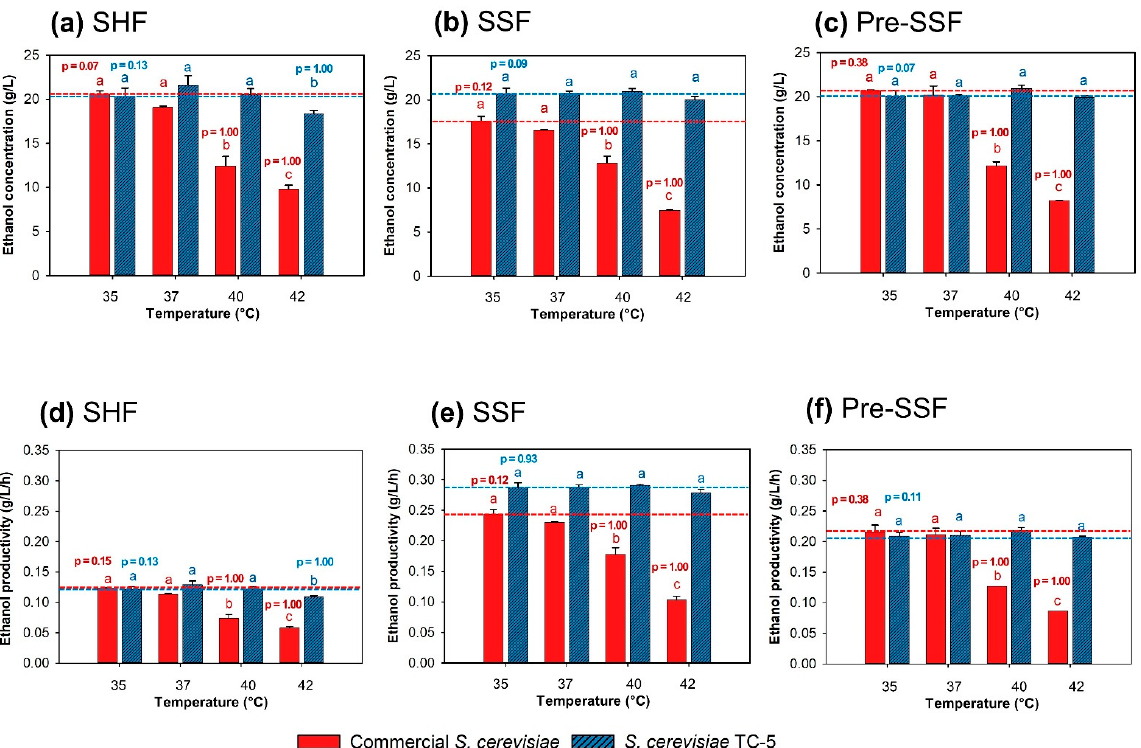
Figure 2. Ethanol production via separate hydrolysis and fermentation (SHF) ( a ), simultaneous saccharification and fermentation (SSF) ( b ), and prehydrolysis-simultaneous saccharification (pre-SSF) ( c ); ethanol productivity via SHF ( d ), SSF ( e ), and pre-SSF ( f ) by commercial S. cerevisiae and thermotolerant S. cerevisiae TC-5 at 35, 37, 40, and 42 °C for 72 h. Note: values are presented as mean ± standard deviation. Different letters above the bars denote statistically significant different. The level of significance was tested by Duncan’s multiple range test. Bar chart with the same pattern and letter are not significantly different (ethanol concentration or productivity of each yeast strain were compared between temperature).